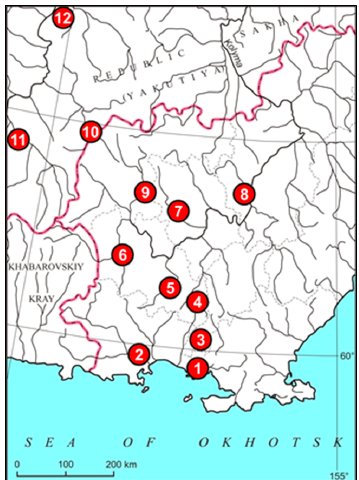
Figure 4. Location of weather stations, of which their data (Table 5) reflect the winter temperature gradient (°C) from the coast of the Sea of Okhotsk to the upper reaches of the basin of the Indigirka River. Yakutsk (No 13 in Table 5) is located off the map.